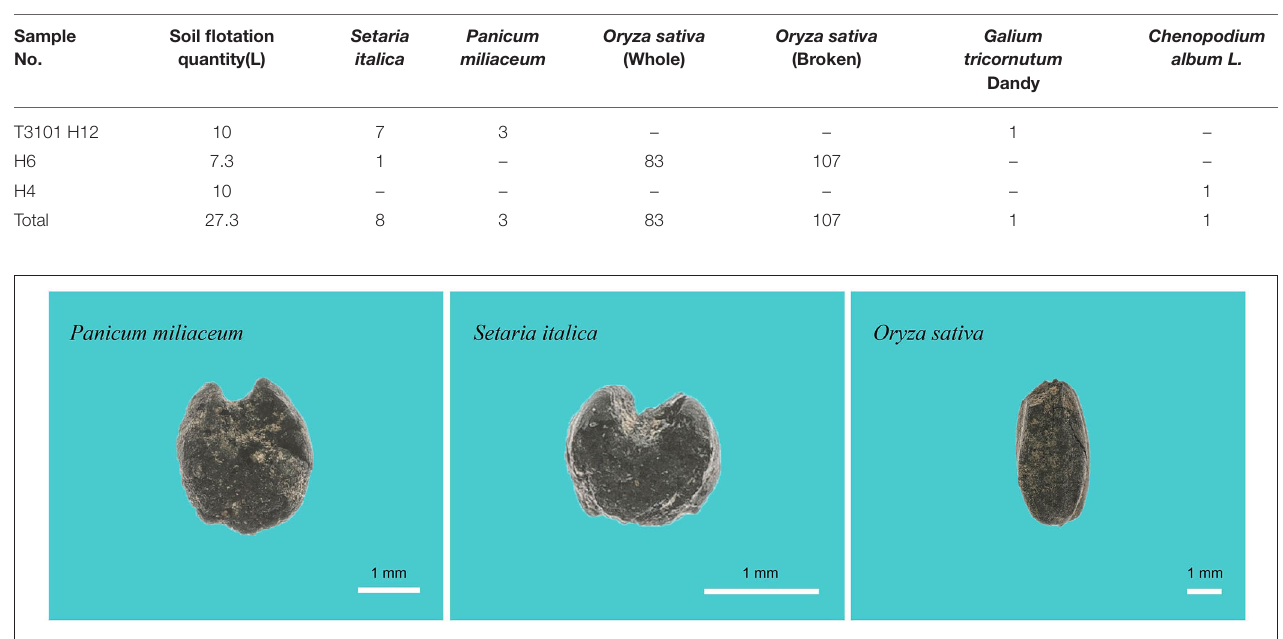
FIGURE 3 | Remains of crops identified at the Jiangxifen